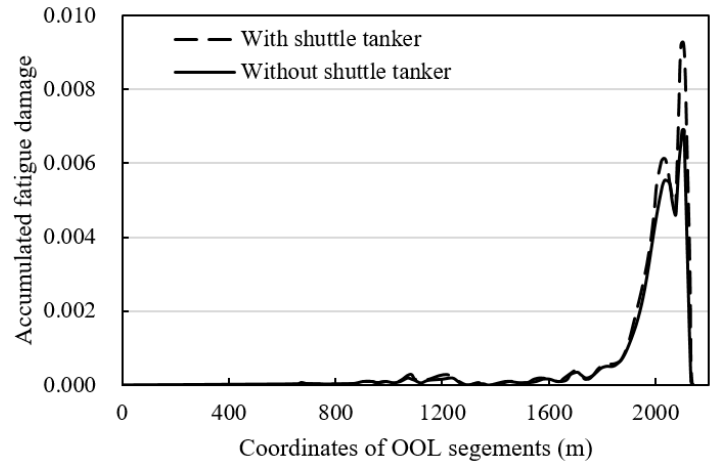
Figure 18. Influence of shuttle tanker on fatigue damage of OOL.